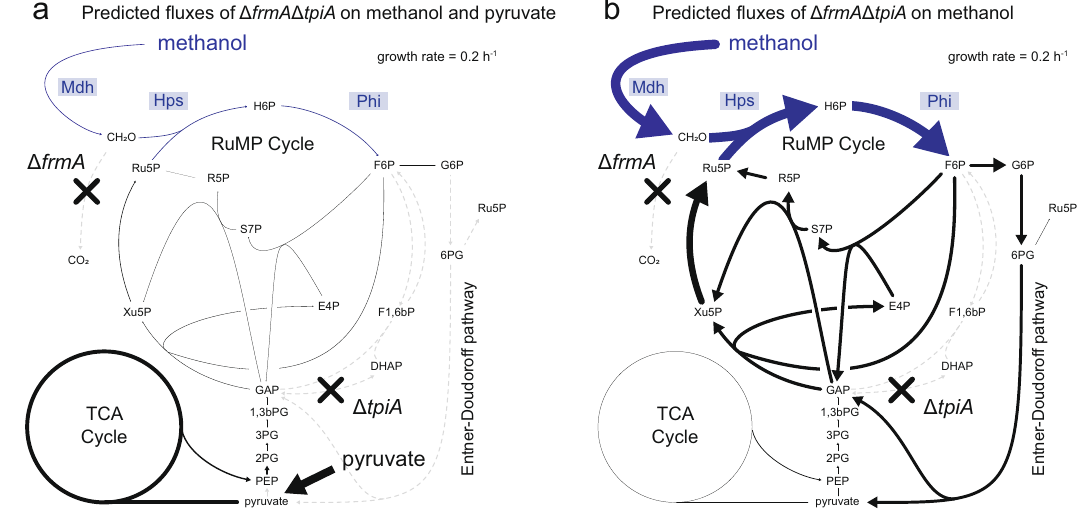
Fig. 1 | Differences of the fl ux distribution of the methanol-dependent strain Δ frmA Δ tpiA on methanol and pyruvate and methanol alone. FVA-predicted average metabolic fl uxes in strain Δ frmA Δ tpiA ata set growth rate of 0.2h − 1 during growth on methanol and pyruvate as co-substrates ( a ) and methanol as the sole carbon source ( b ) Due to the higher ef fi ciency of E . coli to metabolize pyruvate, pyruvate was provided in excess and methanol at limiting concentrations during co-consumption.Theminimalamountofmethanolrequiredtoachievethegrowth rate was considered. The TCA cycle fl ux value originates from the fl ux through the citrate synthase reaction. Metabolic reactions that were synthetically introduced intothemetabolismof E . coli andthecorrespondingenzymesaredepictedinblue. Gray, dashed lines indicate zero fl ux through the reaction. Mdh